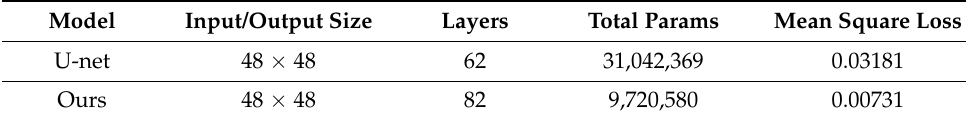
Table 2. Model parameter